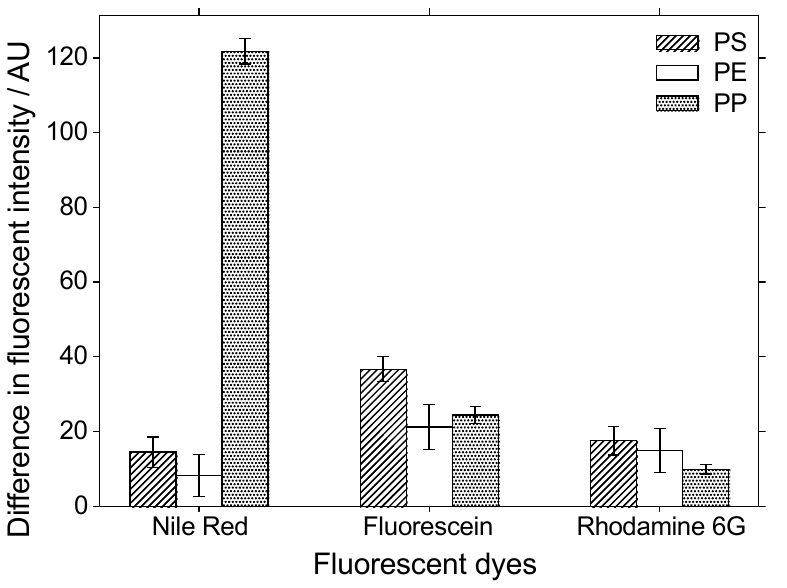
Figure 5. Bar graph illustrating the difference in fluorescent intensity values between stained and non-stained PS, PE, and PP microplastics after immersion in ethanolic solutions of Nile Red, Fluorescein, and Rhodamine 6G fluorescent dyes. The values were derived by subtracting the intensity of non-stained particles from that of stained particles ( n ≥ 6).